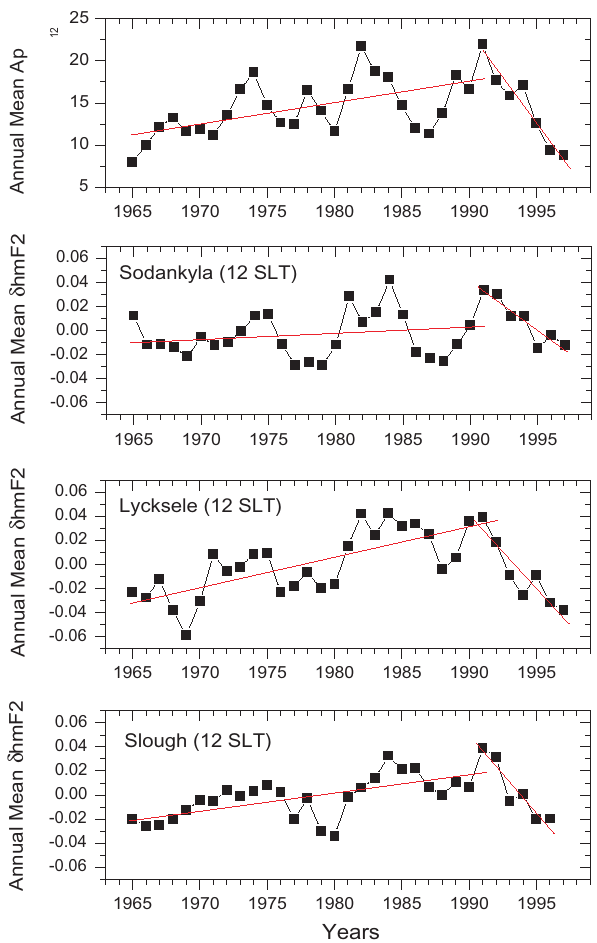
Fig. 6. Annual mean Ap 12 and δhm F2 variations at Sodankyla, Lycksele and Slough, and 12 SLT (Model 1). Note different signs of trends for the period prior and after